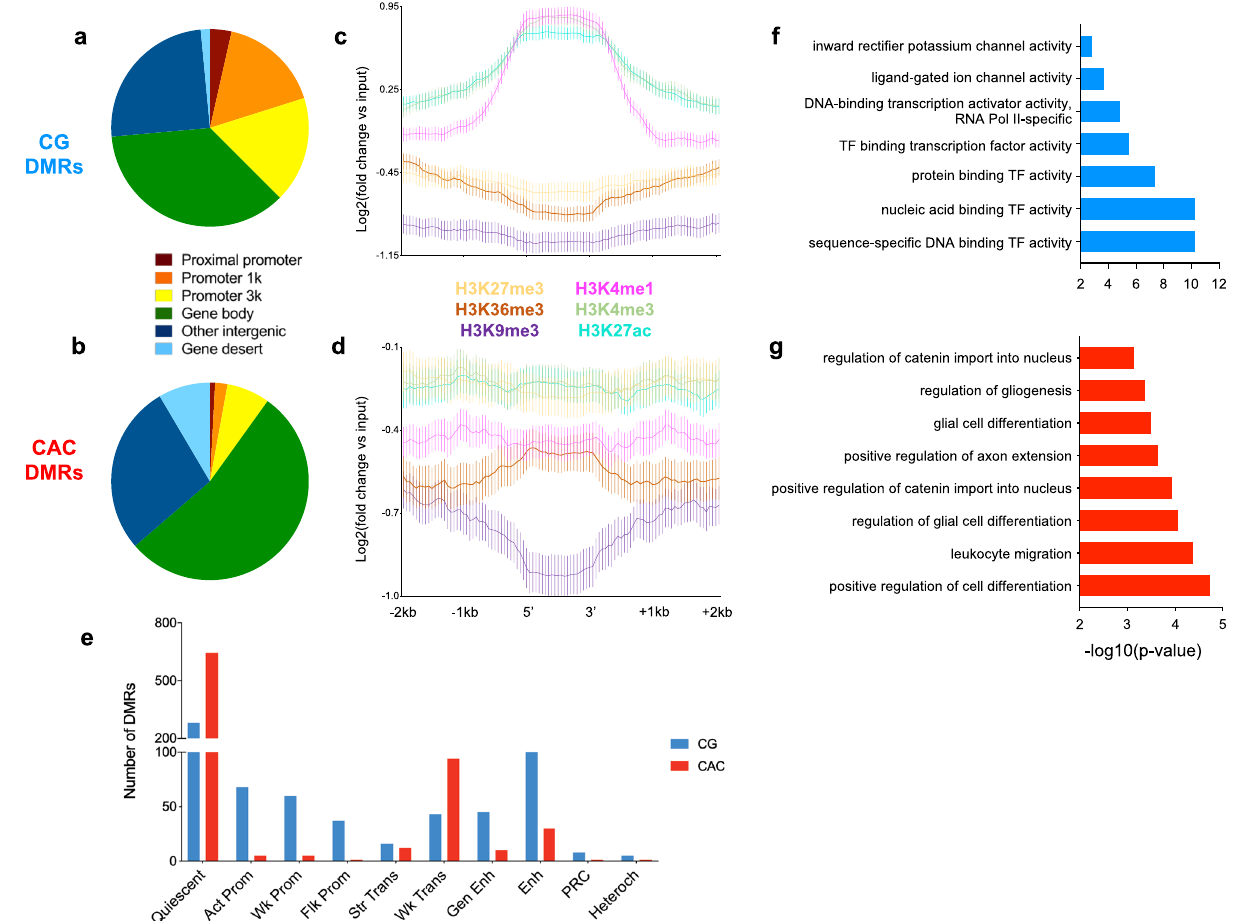
Fig. 6 Individual histone marks and global chromatin states de fi ning genomic regions where early-life adversity (ELA) associated with differential DNA methylation. a , b Localization of differentially methylated regions (DMR) in genomic features, identi fi ed using region_analysis 34 . Distributions were strongly different among CG and CAC contexts (chi-square test: χ 2 = 221.2, df = 6, P < 2.2E-16). c , d Histone modi fi cations measured at the level of DMRs and their fl anking regions ( + / − 2 kilobases, kb). Distributions were very distinct between CG- and CAC-DMRs, with signi fi cant interactions between cytosine context and cytosine position along DMRs, for each of the six marks (two-way repeated-measures ANOVA interactions, P < 0.0001 for all; see also Supplementary Fig. 14a). Values are mean ± sem. e Chromatin states found at DMRs. Similarly, CG- and CAC-DMRs occurred in very different chromatin states (chi-square test: χ 2 = 390.4, df = 9, P < 2.2E-16). f , g Gene Ontology analysis of CG- and CAC-DMRs using GREAT 36 (see main text). Act-Prom active promoter, Enh enhancer, Flk-Prom fl anking promoter, Heterochr heterochromatin, PcR polycomb repressed, Str-Enh strong enhancer, Str- Trans strong transcription, Wk-Prom weak promoter, Wk-Trans weak transcription. Source data are provided as a Source Data fi le.